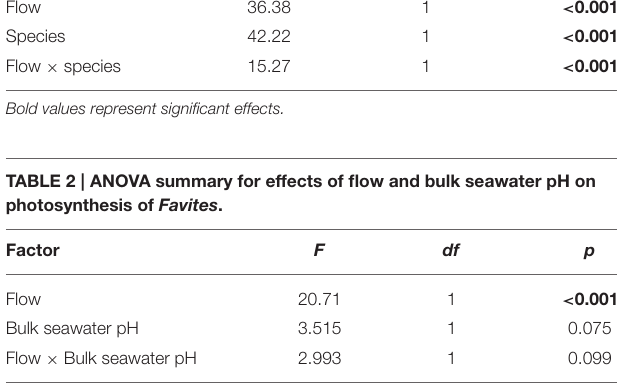
Bold values represent significant